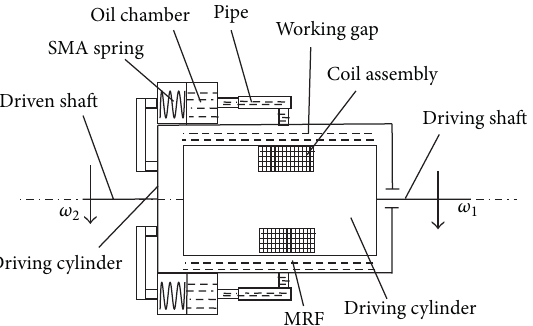
Figure 1: MR fluid shear transmission driven by SMA between two cylinders.